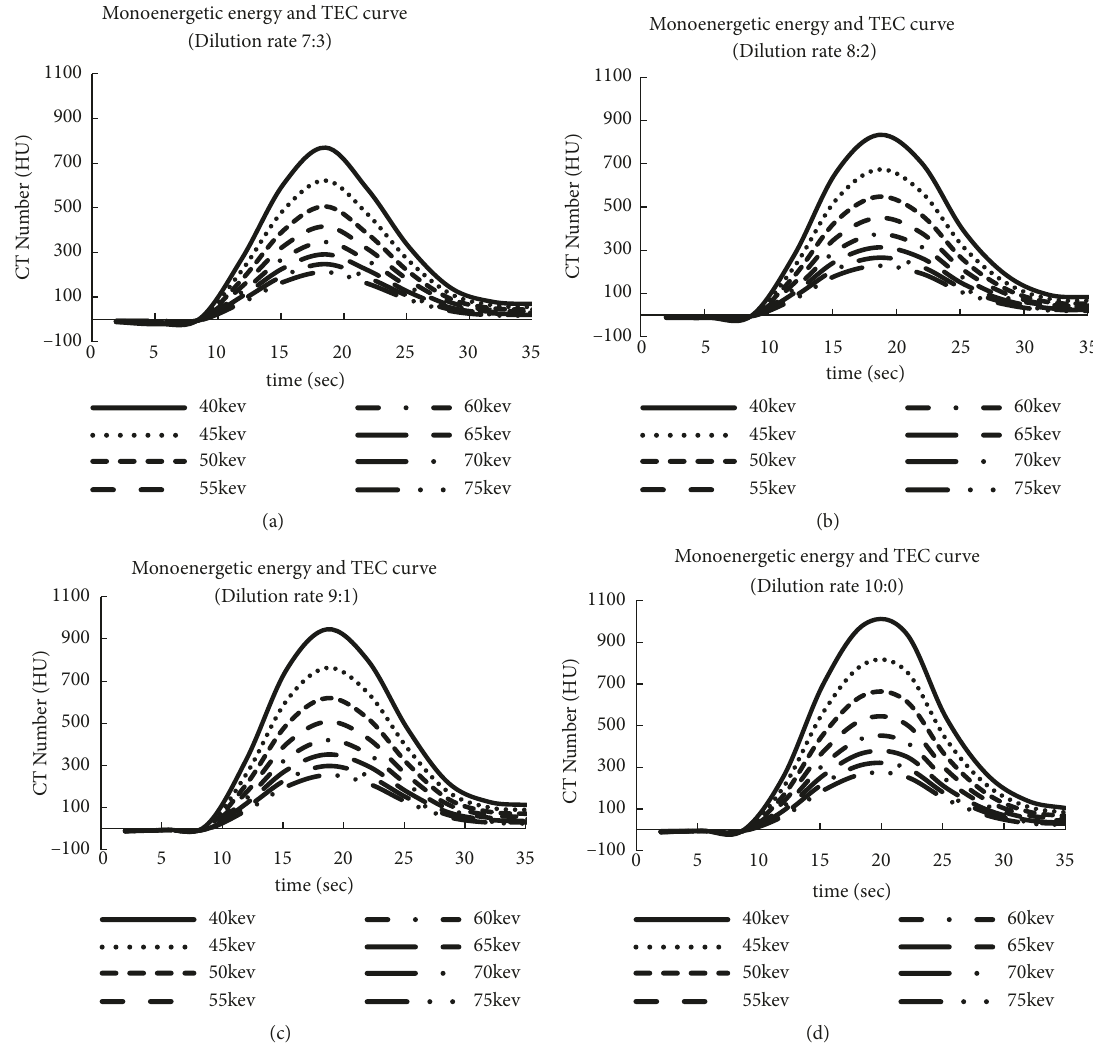
Figure 6: Monoenergetic energy and TEC. (a) Dilution rate 7:3; (b) dilution rate 8:2; (c) dilution rate 9:1; (d) dilution rate 10:0.